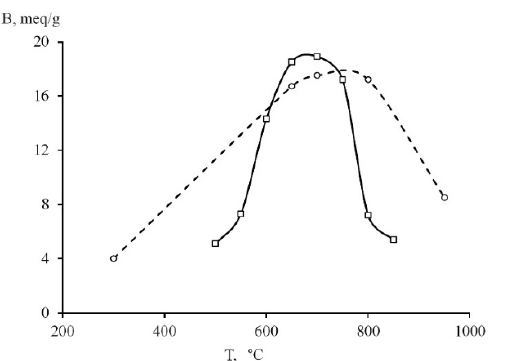
Figure 4. Dependence of the acid-neutralizing ability of serpentine (B, meq/g) on the roasting tem- temperature for the MF series (– (cid:3) –) and RF series (– perature for the MF series (– □ –) and RF series (-- ○ --) samples.